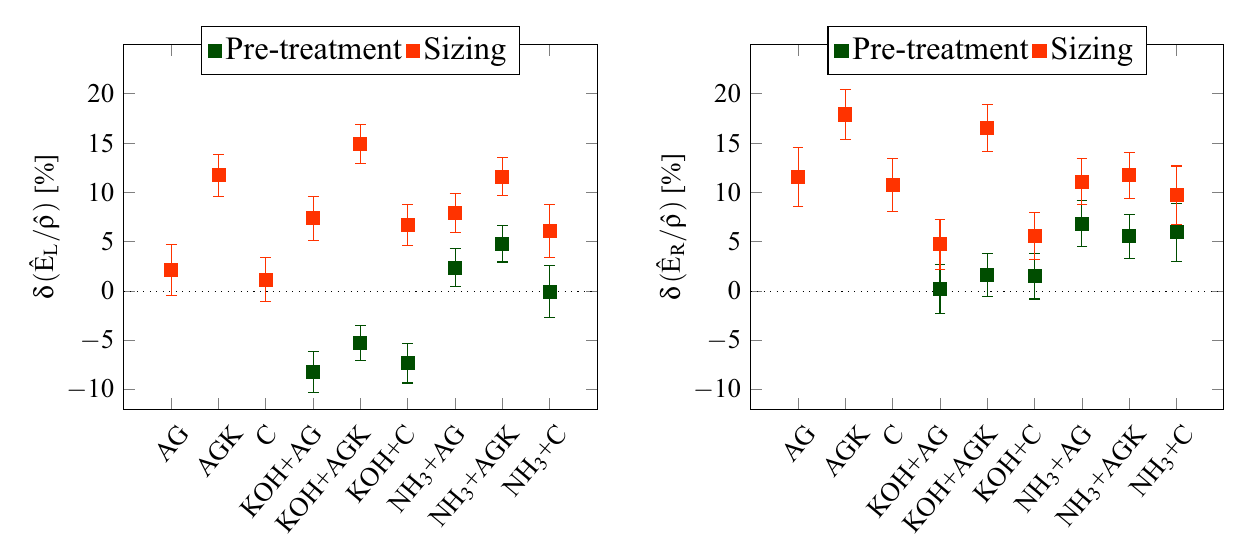
Figure 3. Relative variation in the longitudinal and radial specific stiffness observed at the end of each treatment stage (green: pre-treatment, orange: sizing). Values are expressed in percentage and represented with squares. Error bars represent the estimation error. Left: Estimated variation for the longitudinal specific stiffness δ( ˆ E L / ˆ ρ) , with a maximum error of 2.7%; Right: Estimated variation for the radial specific stiffness δ( ˆ E R / ˆ ρ) , with a maximum error of 3.0%. Estimations are based on Caldersmith’s equations 26 , assuming the contribution of Poisson’s ratios as